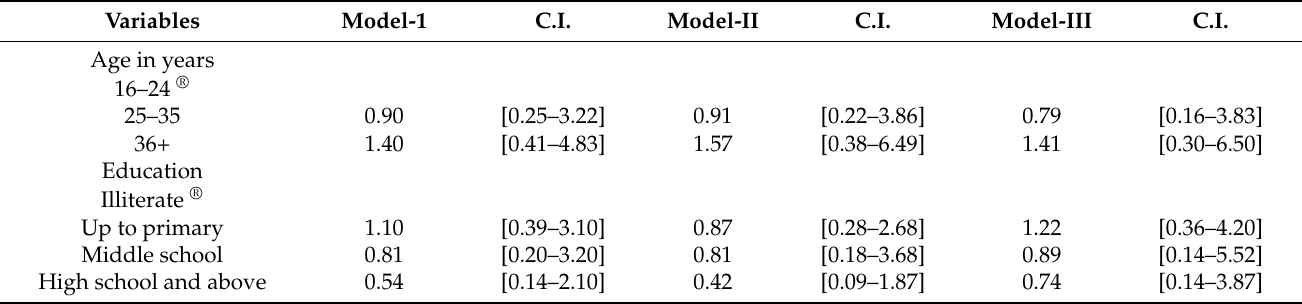
Table 4. Odds ratio showing risk factors of sinus problems among tannery workers (12 months preceding the survey) in Kanpur, India,